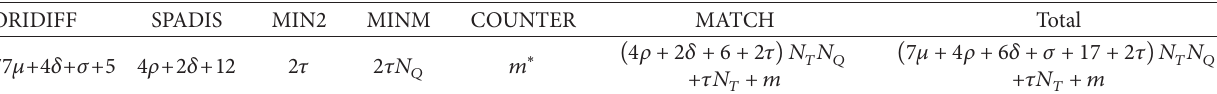
Figure 6: ROC curves for authentication. (a) Euclidean distance, (b) city block distance. Table 3: Number of non-XOR gates in circuit for Euclidean